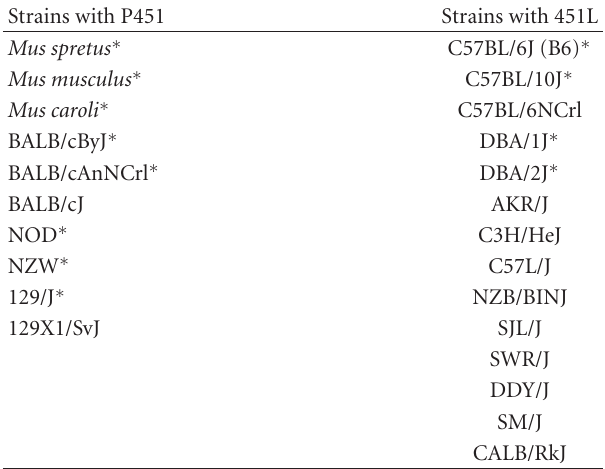
Table 1: The distribution of the strains in two groups with di ff erent allelic versions of the P451L mutation. Strains written in italic are outbred or mice from wild populations. ∗ Confirming the data also shown by Adriouch et al.